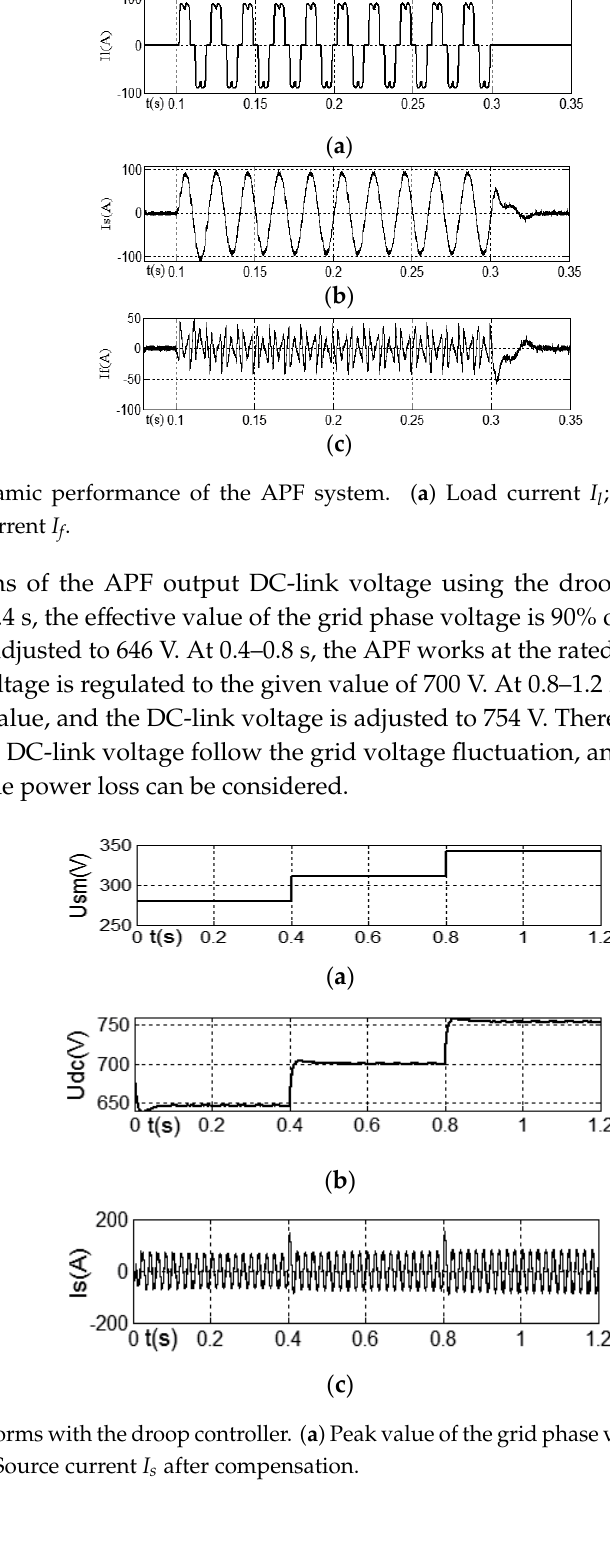
Figure 6. Simulation waveforms of APF with source current control method. ( a ) Load current and its